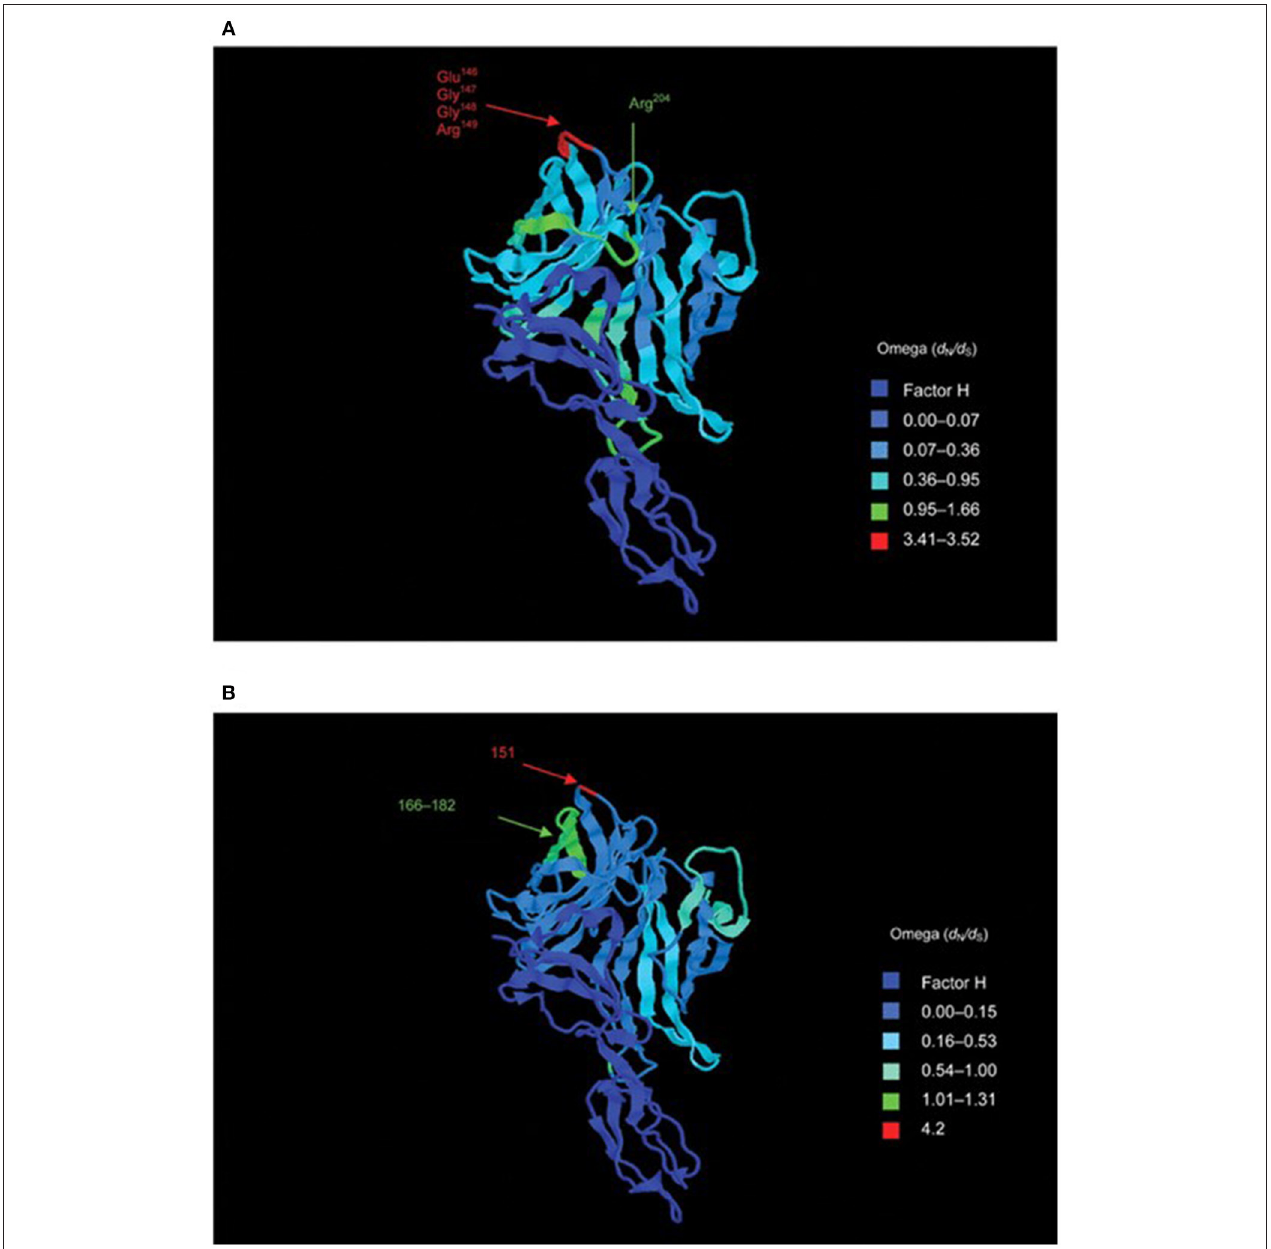
FIGURE 5 | Structure of the fH–fHbp complex, with temperature coloring using per-site point estimates of selection ( ω ) for (A) subfamily B/variant 1 sequences and (B) subfamily A/variant 2 sequences. Peptides indicated in (A) are putative bactericidal epitopes. In (B) positively selected sites are indicated. Note: subfamily A/variant 2 differs in length from subfamily B/variant 1 by + 4 bp (e.g., Glu151 is equivalent to Glu147 in variant 1). Reproduced from Brehony et al. (14) without modification under CC